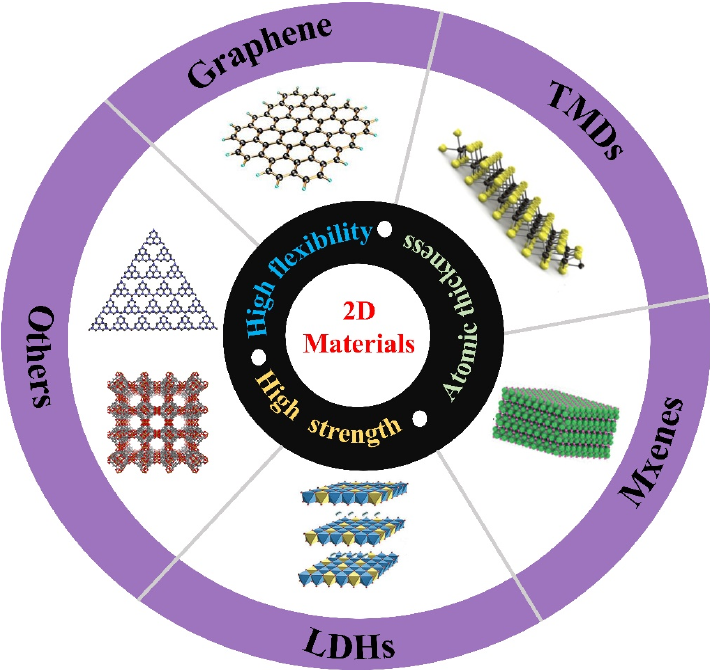
Figure 3. The summery of 2D materials including graphene, TMDs, LDHs, MXenes, and others [38].